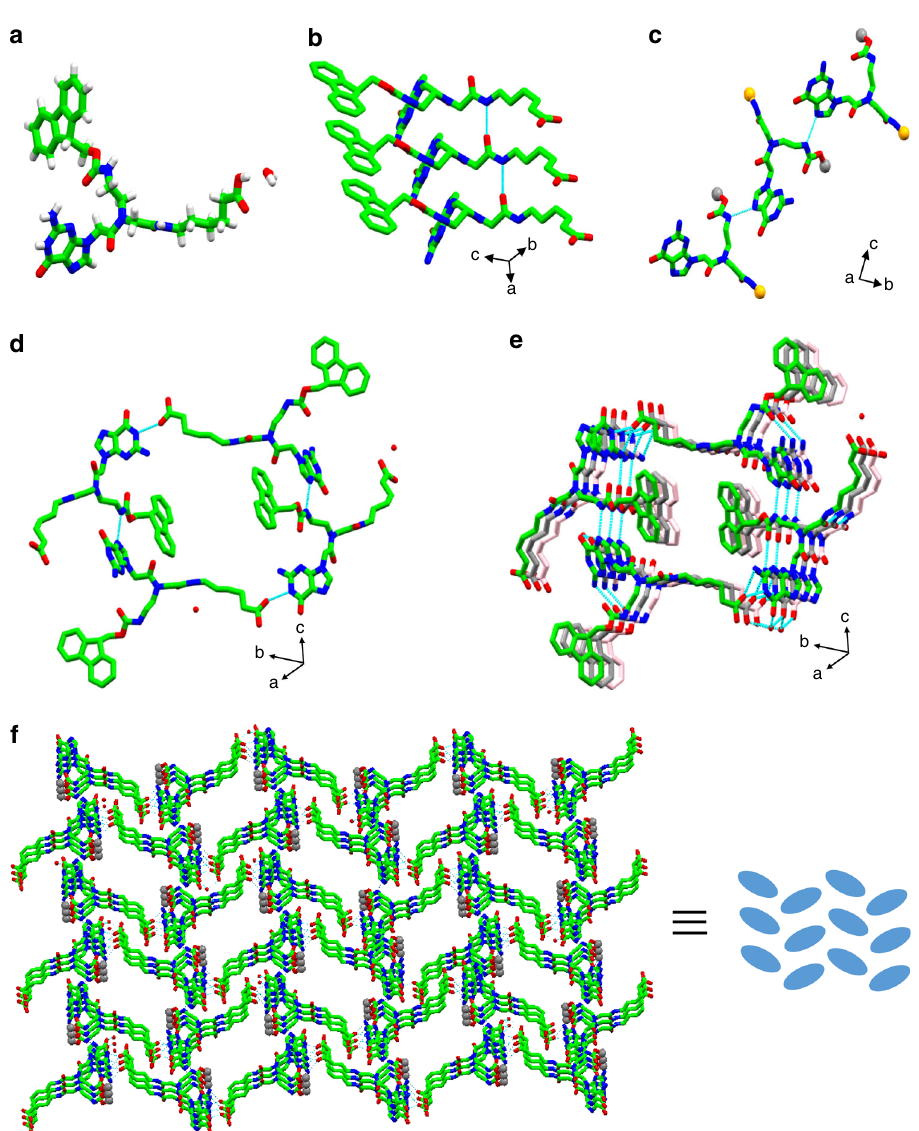
Fig. 2 Single crystal structural analysis of the Fmoc-G-PNA tetramer. a The asymmetric unit. b Supramolecular parallel array of the asymmetric unit, obtained through intermolecular H-bonds and aromatic-aromatic interactions. c Truncated view of a ribbon-like structure formed in the crystallographic ~ c -direction. The Fmoc group and aliphatic chains are represented by gray and orange spheres, respectively. d Non planar cyclic tetrameric structure. e Quadruplex inspired superstructure view down crystallographic ~ a -direction. f Herringbone-like arrangement of the G-wire in a higher-order structure produced by lateral orientation. The H-bonds are shown in light blue dashed lines and the Fmoc rings are represented by a gray